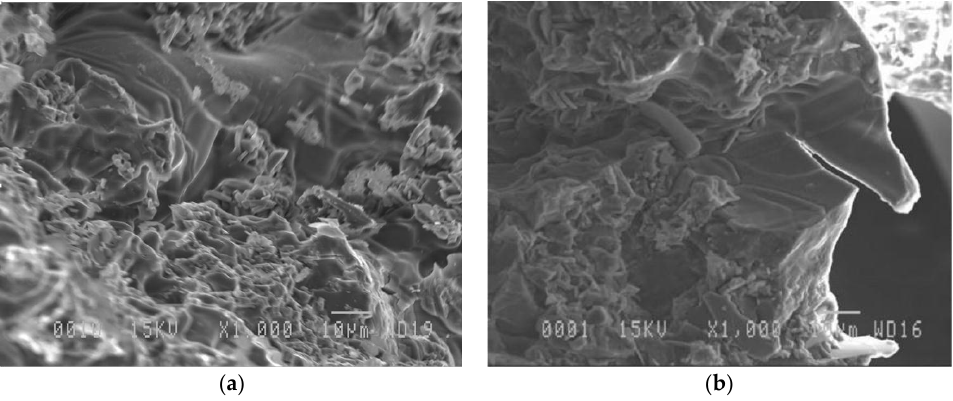
Figure 8. SEM (scanning electron microscope) representative images of investigated zone: ( a ) Zone 1; ( b ) zone 2.